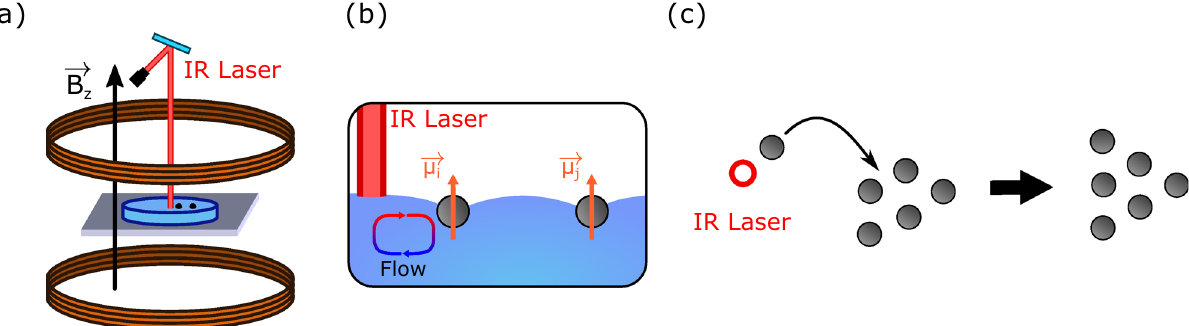
Figure 5. Controlled growth setup. ( a ) Second experimental setup composed of one pair of Helmholtz coils to produce a vertical magnetic field B z and an IR laser to create a hot spot on the liquid interface. ( b ) Side view of the use of the laser-induced thermocapillary flow to bring a magnetic particle closer to another one. The flow pushes the particle away from the laser spot. ( c ) Developed strategy to achieve a desired final state by adding a particle to an existing crystal in a particular